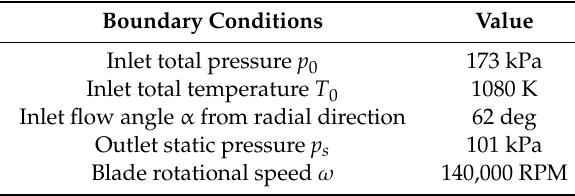
Table 2. Turbine rotor boundary conditions.